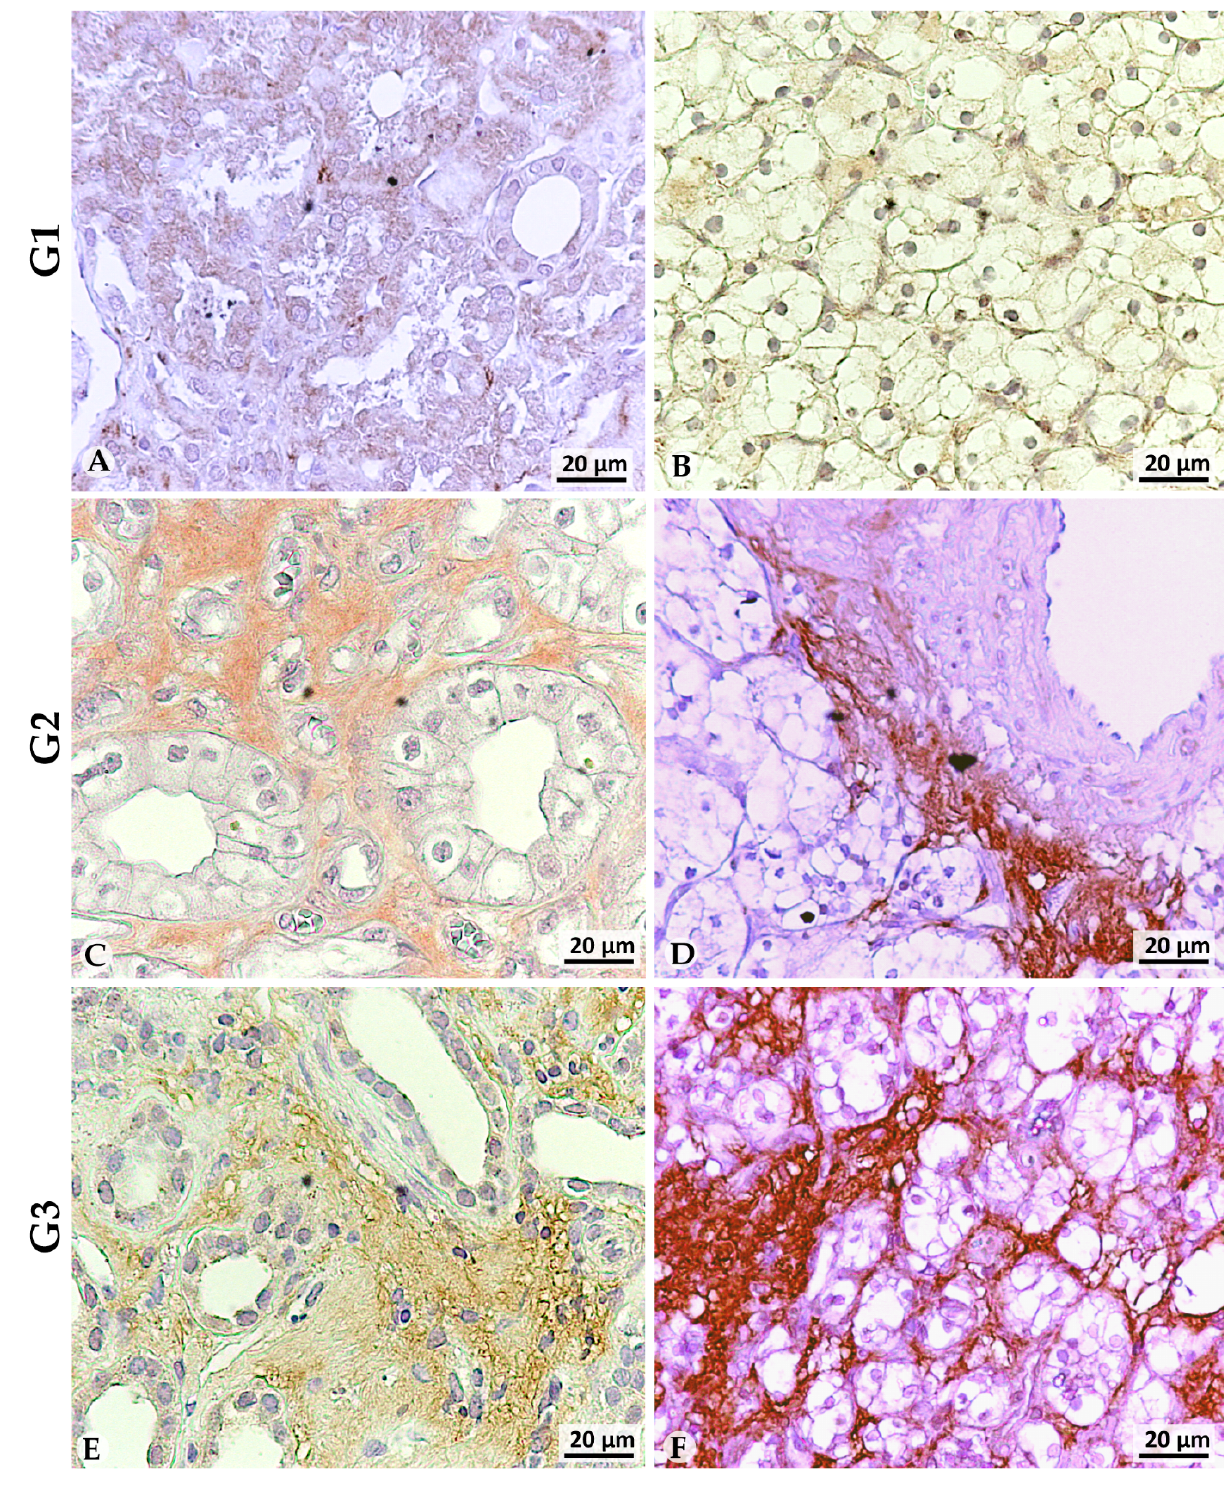
Figure 3. LOX-1 immunohistochemistry analysis in clear cells kidney cancer. ( A ) NpT aside G1 tumor, ( B ) G1 tumor, ( C ) NpT aside G2 tumor, ( D ) G2 tumor, ( E ) NpT aside G3 tumor, ( F ) G3 tumor. Scale bar 20 μm.